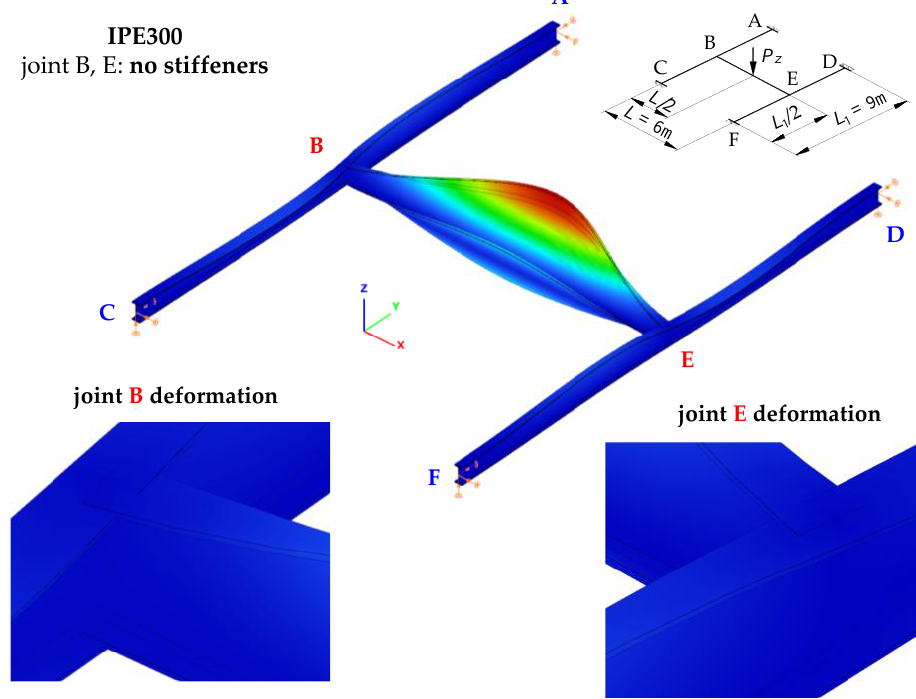
Figure 9. The mode of stability loss in exemplary H-grillage modelled in ConSteel software—thin-walled bar